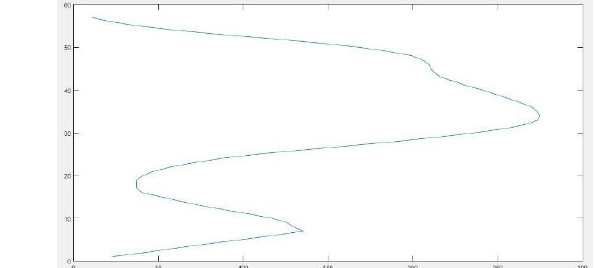
Figure 5.a. The horizontal histogram